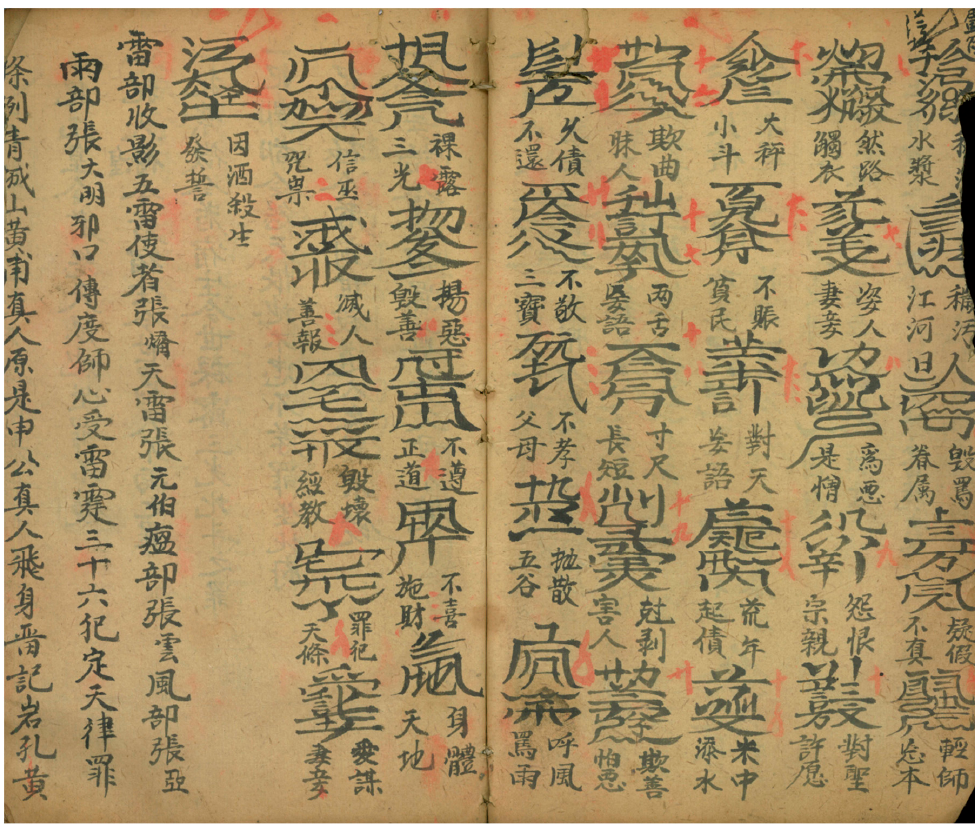
Figure 6. Most High Thunderclap’s Arrayed Seals for Thirty-six Crimes.